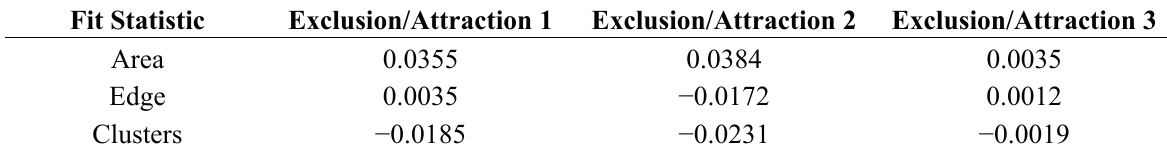
Table 2. Fit statistics, reported as fractional differences between simulated and observed values, for the unconstrained validation